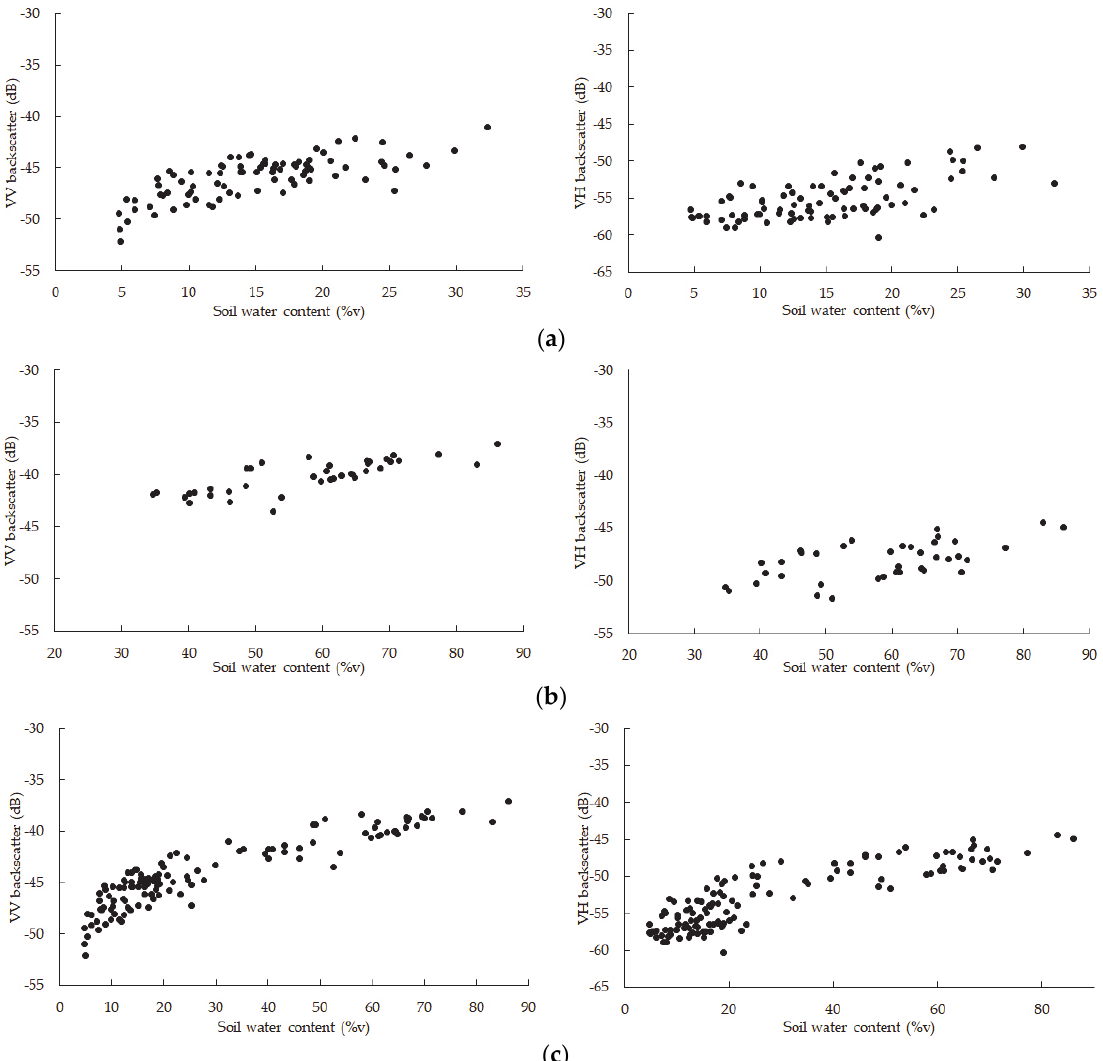
Figure 6. Relationships between soil water content (%v) and backscatter values: ( a ) Relationship between VV ( left ) and VH ( right ) backscatter and soil water content in Kediri; ( b ) Relationship between VV ( left ) and VH ( right ) backscatter and soil water content in Sidoarjo; ( c ) The cumulative relationships of VV ( left ) and VH ( right ) backscatter and soil water content.